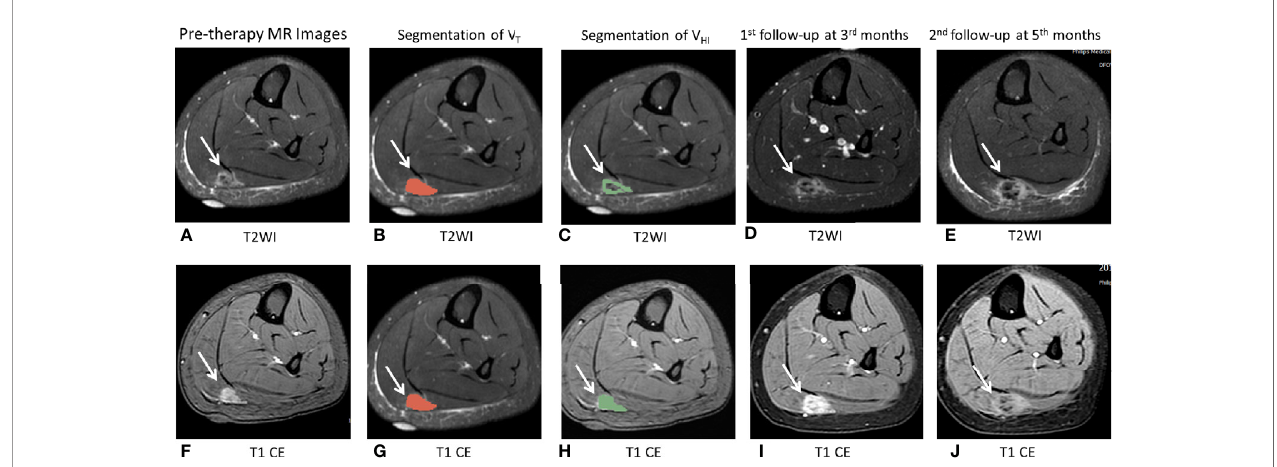
FIGURE 5 | MR images of the representative case. (A – J) , A 16-year-old female patient with DF of right calf muscle with imatinib treatment (arrows). Pre-therapy MR images refer to examination before imatinib treatment. Pre-therapy (A, F) diameter, 20.0 mm; On T2WI, V T = 6,242 mm 3 , V HI = 6,242 mm 3 , HI = 100% (grade = 3); On T1 CE, V T = 6,357 mm 3 , V HI = 6,357 mm 3 , HI = 100% (grade = 3). Segmentation of V T ( B, G , red zone) and segmentation of V HI ( C, H , green zone). 1 st follow- up at 3 months after imatinib treatment (D, I) Diameter, 23.5 mm indicates a 17.5% increase in tumor size as well as a decrease in T2 and T1 CE signal intensity.